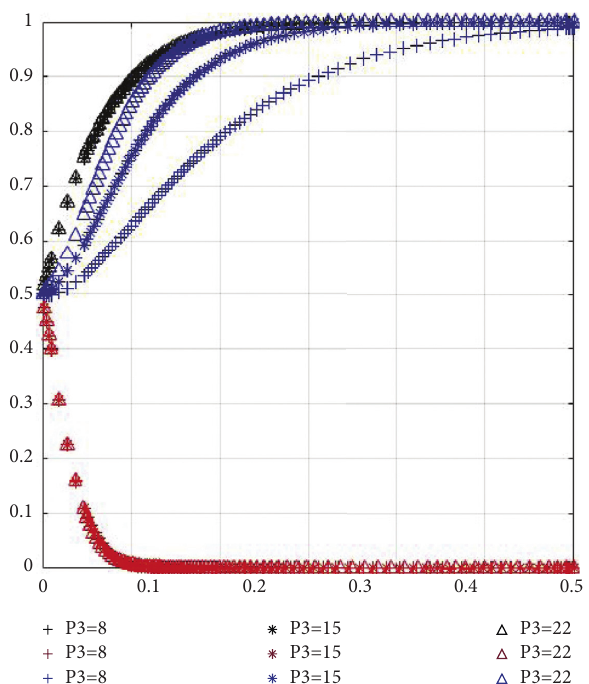
Figure 12: Public’s revenue affected by positive information re- leased by We Media ( P 3 � 8 ⟶ P 3 � 15 ⟶ P 3 � 22).